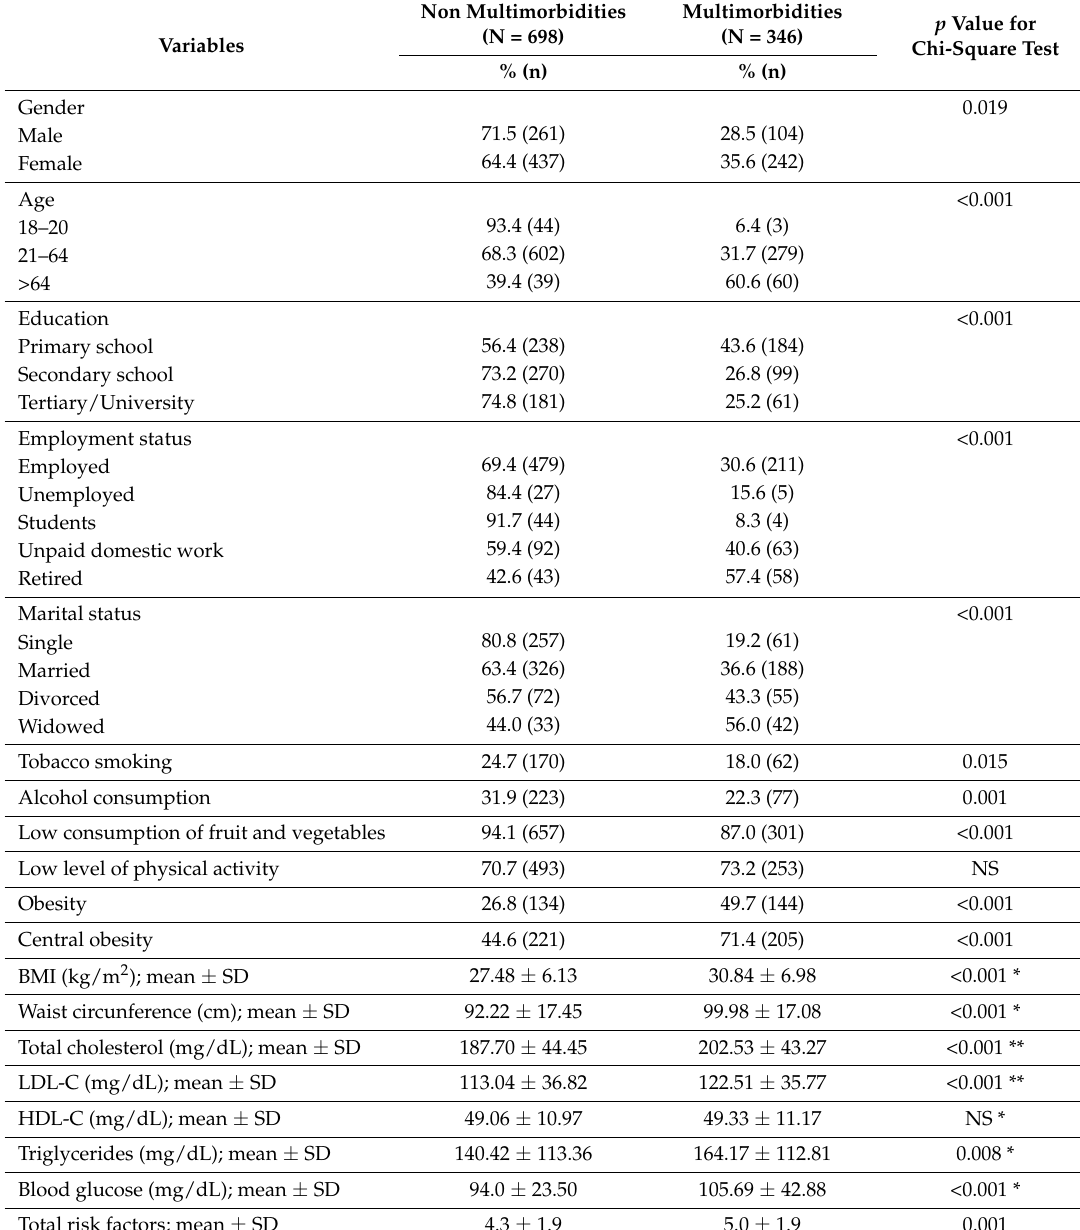
Table 5. Sociodemographics, lifestyle, anthropometry and blood biochemical profile in patients with